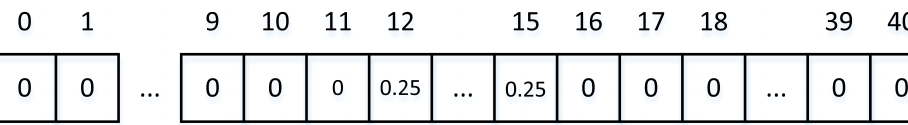
Figure 4. An example of ‘HCP = 12 ∼ 15’